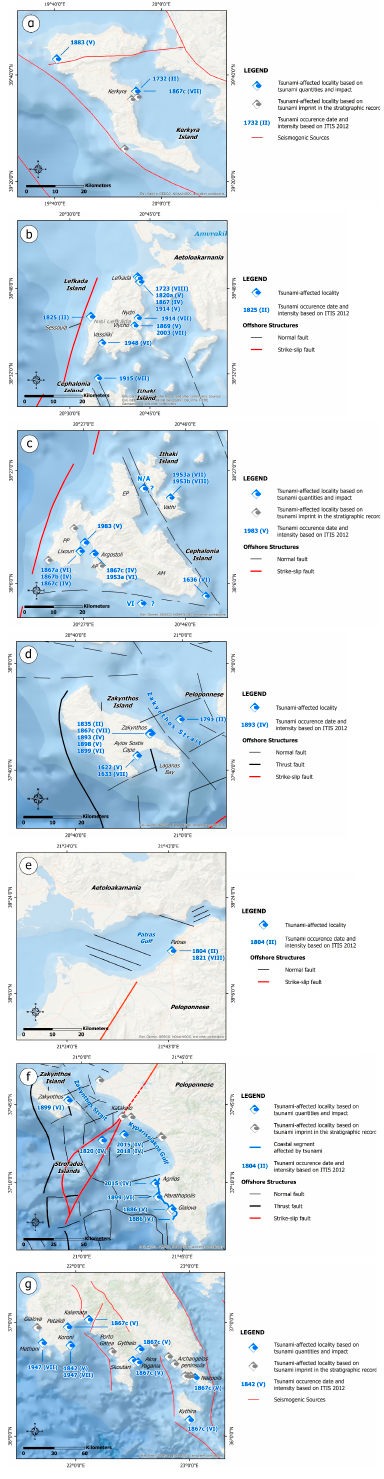
Figure 8. The localities in the Ionian Islands and western and southern Peloponnese affected by earthquake-triggered tsunamis along with the assigned ITIS-2012 tsunami intensities. ( a ) Kerkyra, ( b ) Lefkada, ( c ) Cephalonia and Ithaki, ( d ) Zakynthos and ( e , f , g ) the Peloponnese with its north- western ( e ), western ( f ) and southern ( g ) coastal segments, respectively. More details for tsunami- affected areas are available in the Supplementary Materials (Tables S1 and S2 and Supplementary Figures S1–S34). Faults in ( a , g ) from Caputo and Pavlides [36], and those in ( b – e ) from Makris et al. [81]. Table 3. Tsunamigenic earthquakes in the Ionian Sea and offshore western and southern Pelopon- nese, along with the areas with noticeable effects, localities with assigned ITIS-2012 tsunami inten- sities and ITIS 2012 maximum intensities for each event. More details on the physical quantities and the impacts of the earthquake-triggered tsunamis on the coastal part of the study areas are available in Supplementary Tables S1 and S2.